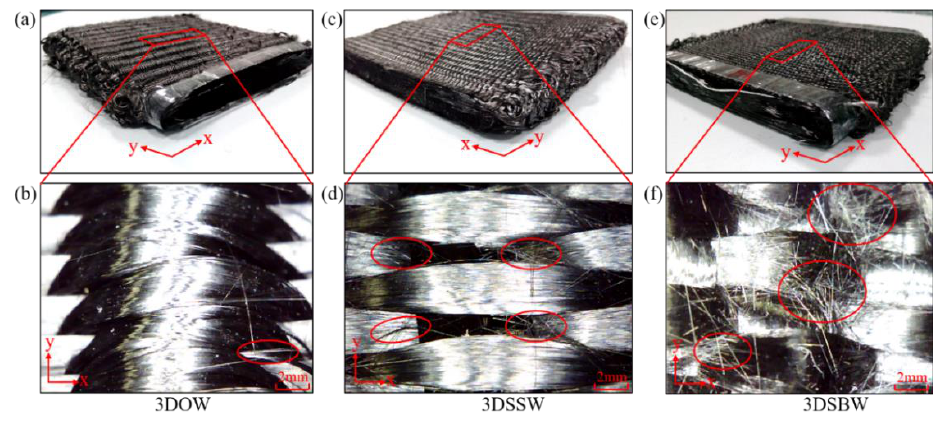
Figure 2. The morphology of three woven fabrics ( a , b ) 3DOW, ( c , d ) 3DSSW, ( e , f ) 3DSSW.